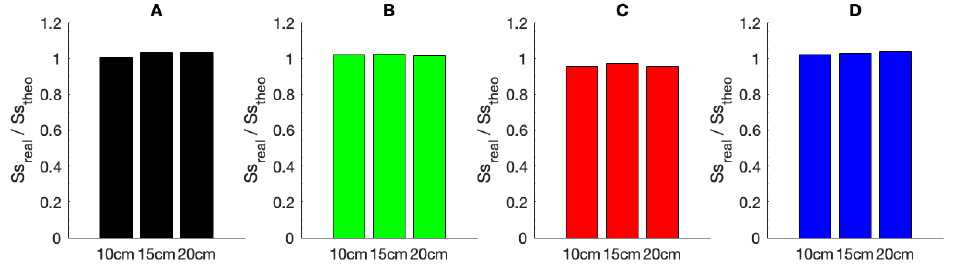
Figure 17. Ratio of realised ( S s